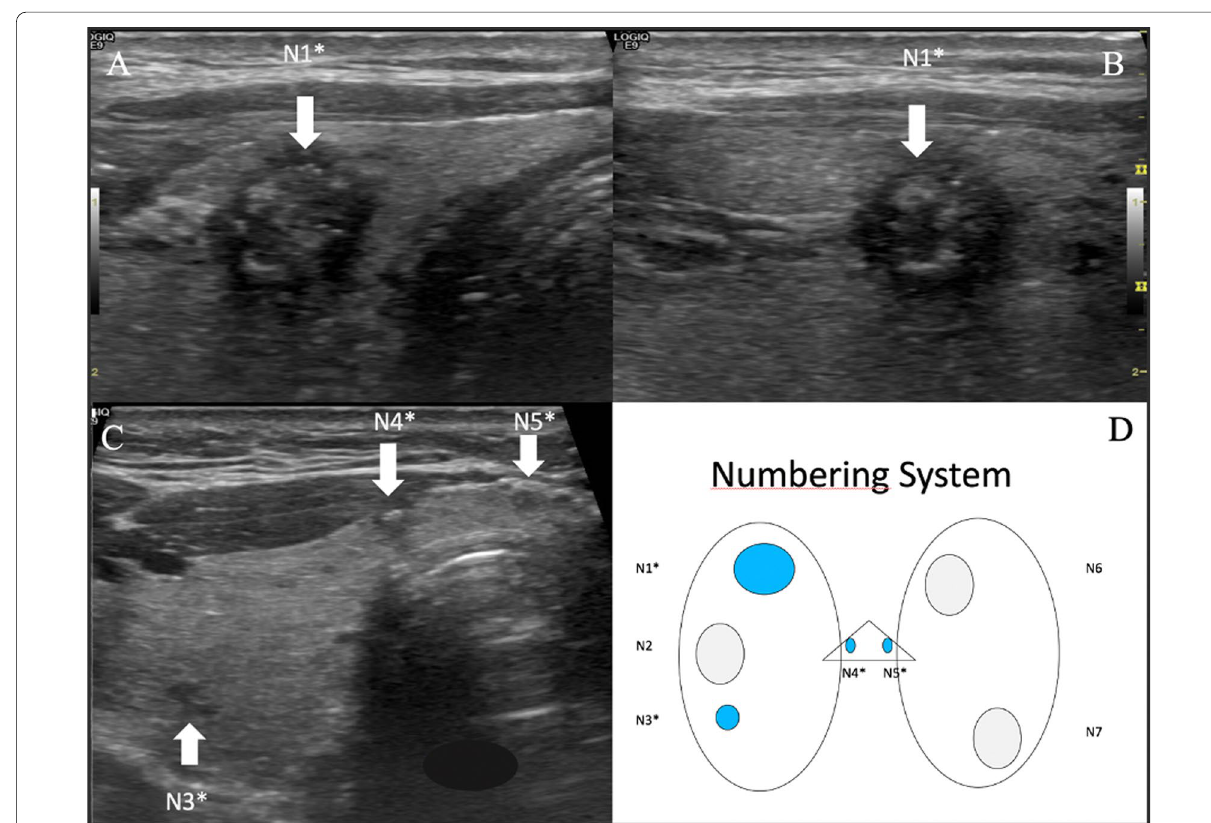
Fig. 1 Thyroid nodule labelling and numbering at study outset (and follow- up). A Axial US scan of upper right lobe of thyroid gland. B Sagittal scan of right lobe. C Axial scan of right lobe and isthmus. D Diagram. Nodules are numbered from upper to lower lobe from right to left. In case of multifocal malignant nodule, various tumour foci are identified on US scan ( A – C ) as N1*, N3*, N4* and N5*, and reported on the diagram ( D ). Sum of each focus is calculated: 7 mm (upper right lobe) 3 mm (lower right lobe) 3 mm (isthmus) 2 mm (isthmus) 15 mm (pT1b) ( D ). Note that + + + = considering the only main tumour focus (N1) leads to pT1a diagnosis according to the TNM classification. Echogenic foci should be differentiated from comet tail artefacts and are considered as psammoma body microcalcifications and be